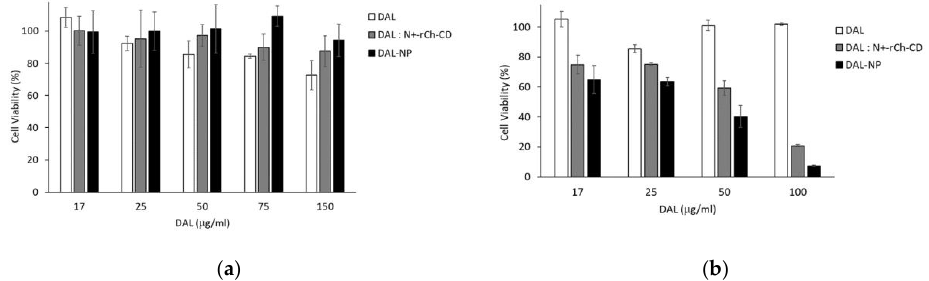
Figure 4 . Cytotoxicity studies with ( a ) Caco-2 cell line, and ( b ) bEnd.3 cell line. The samples tested had equal DAL content, as free DAL (DAL), or DAL complexed with polymer (DAL/N + -rCh-CD), or as nanoparticles (DAL-NP). Data are the means ± standard deviation (SD) of three independent experiments.